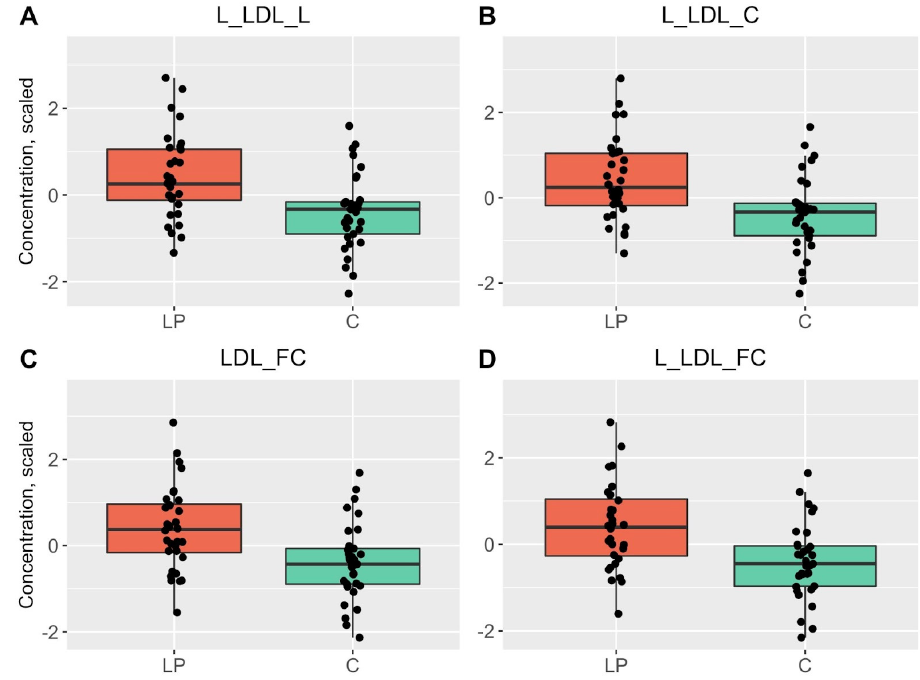
Figure 1. Boxplots of the top four statistically significant results that had differences between the blood samples of LP patients (red) and HC (green). p < 0.0029 is considered statistically significant. Additionally, smaller changes in the composition of high-density lipoproteins (HDL) and VLDL as well as in the concentration of non-HDL cholesterol, sphingomyelins, linoleic acid (LA), polyunsaturated fatty acids (PUFA), omega-6 fatty acids and amino acid leucine (Leu) were also detected; however, the changes were not statistically significant (Table